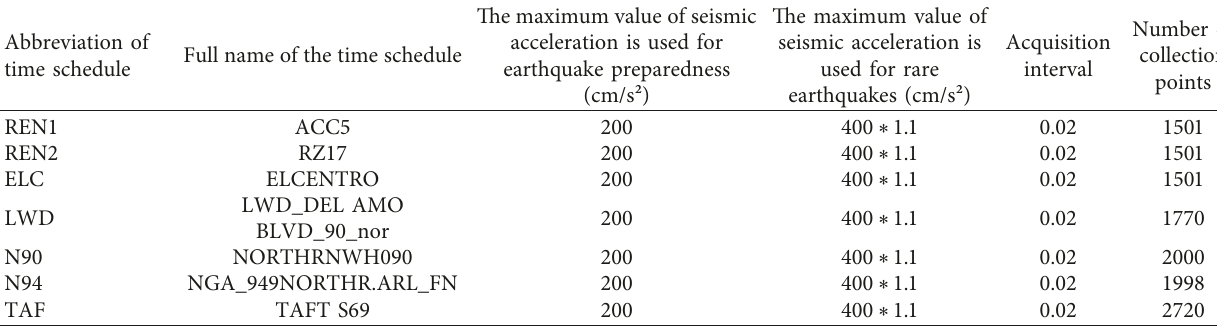
Table 4: Timing information table.